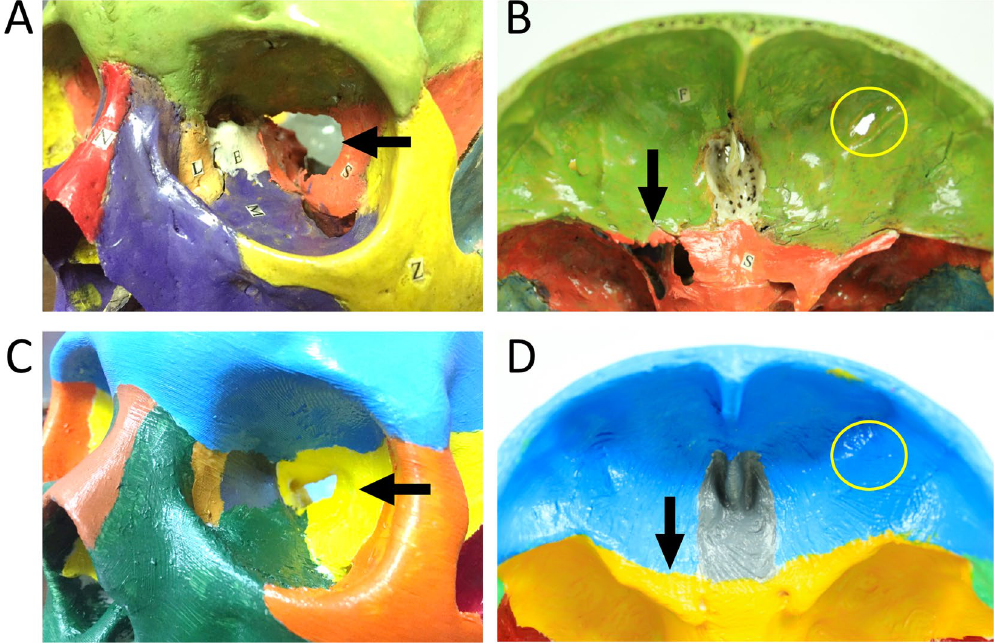
Figure 2. Comparison between the repaired structures of cadaveric skull and printed skull. ( A , C ) Orbit of cadaveric and 3D-printed skull, respectively. ( B , D ) part of anterior view of cadaveric and 3D-printed skull, respectively. Comparison of superior orbital fissure (black arrows in ( A , C )), anterior clinoid process (black arrows in ( B , D )), and small holes on frontal bone (yellow circle in ( B , D )) between cadaveric skulls and 3D-printed skulls are shown.